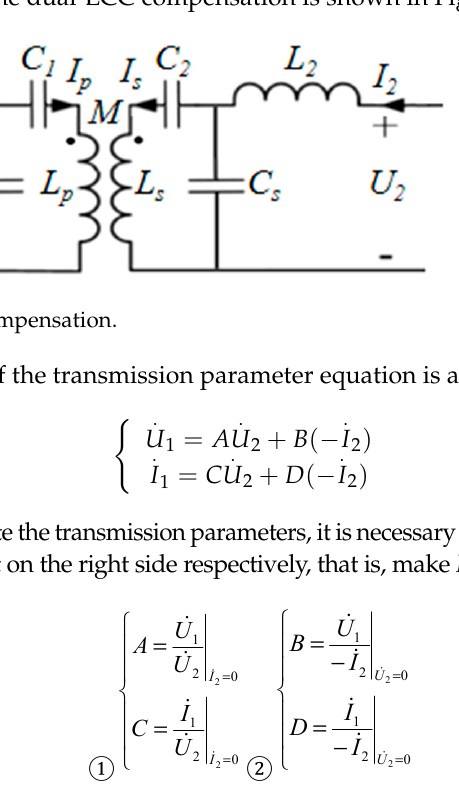
Figure 16. Transmission efficiency characteristic curve of dual-LCC system under different param- eters: ( a ) transmission efficiency—coupling coefficient, ( b ) transmission efficiency—load.